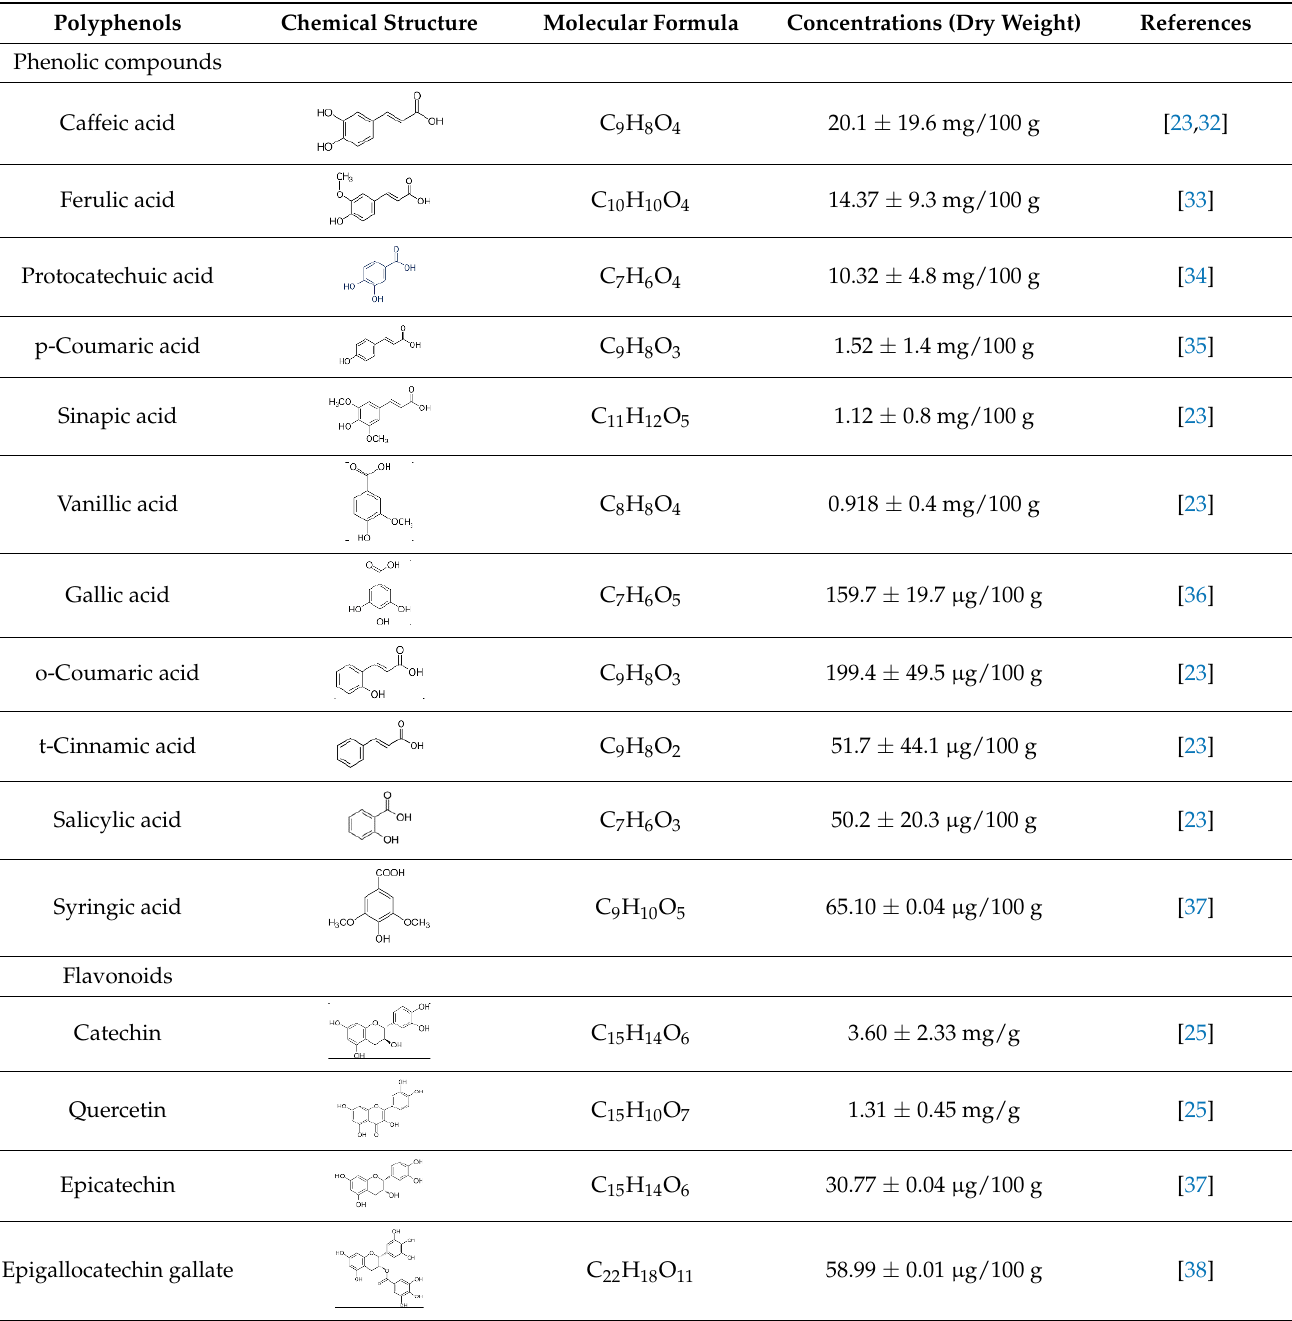
Table 2. Identification of phenolics and flavonoids present in red pitaya. Polyphenols Chemical Structure Molecular